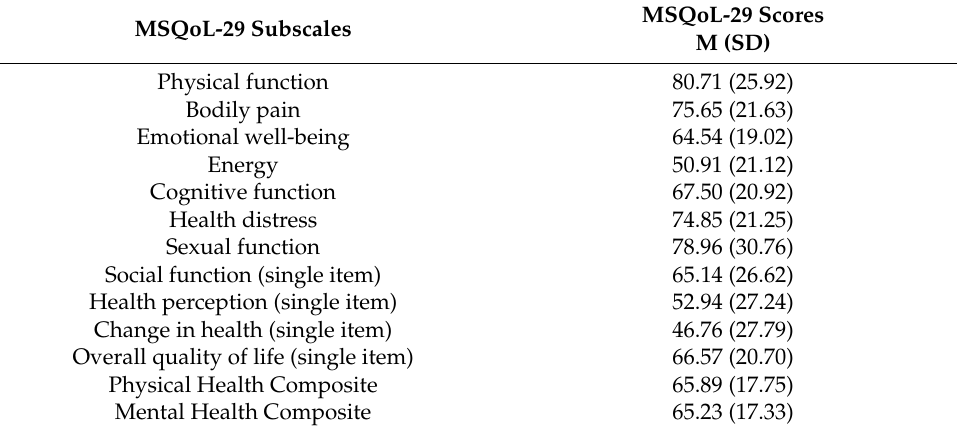
Table A2. MSQoL-29 scores obtained by patients with MS.